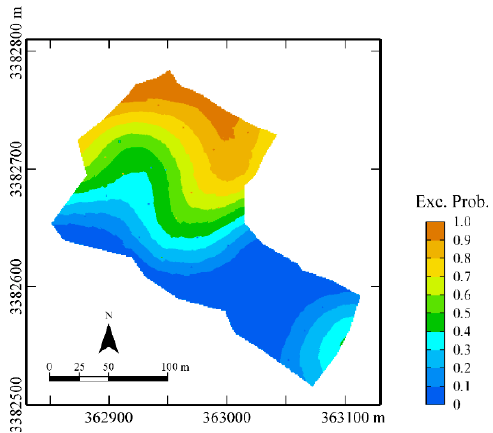
Figure 3. Cokriged map of the probability of ECe exceeding the critical threshold.